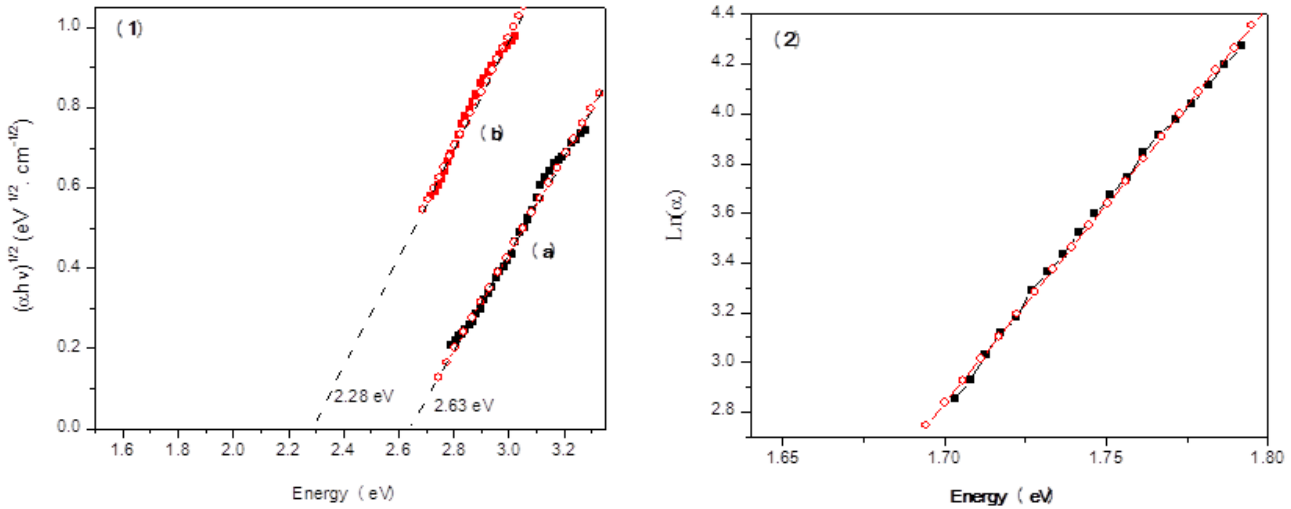
Figure 9. ( 1 ): Variation of the optical gap (a) sulfonic acid-doped PANI and doped PANI functionalized with SWCNTs ( 2 ): Evaluation of the localized states’ parameters ( (cid:4) ): experimental. (o): linear fit.